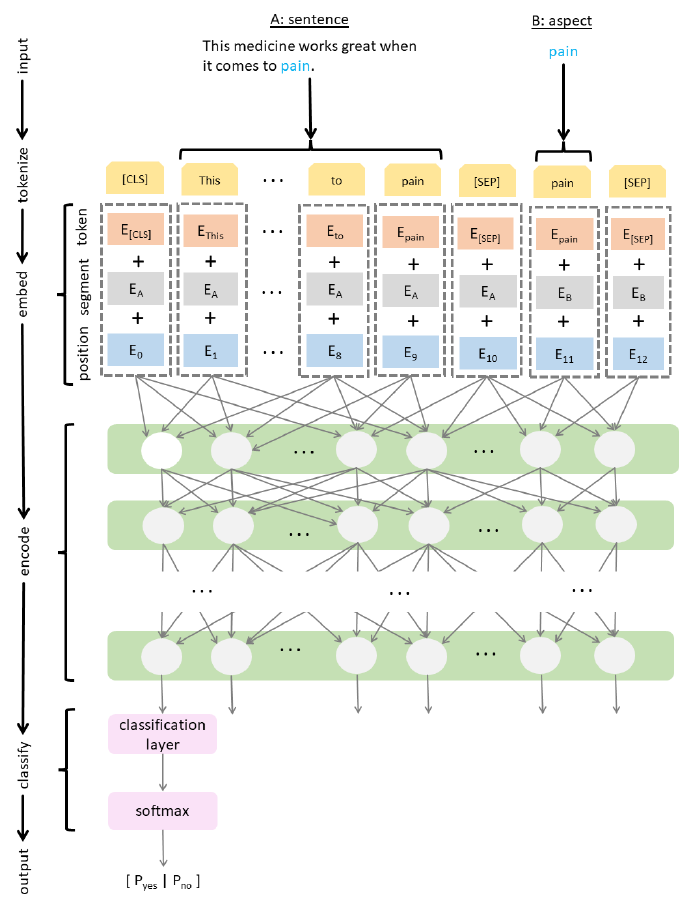
Figure 1. BERT-based architecture for aspect-based